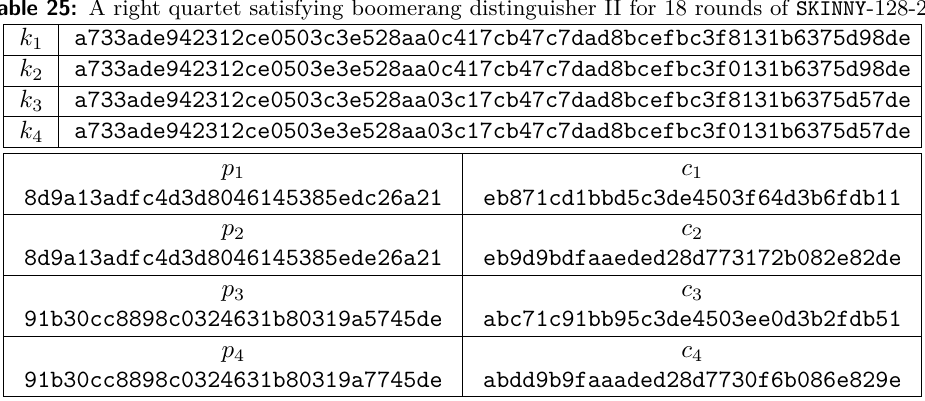
Table 25: A right quartet satisfying boomerang distinguisher II for 18 rounds of SKINNY